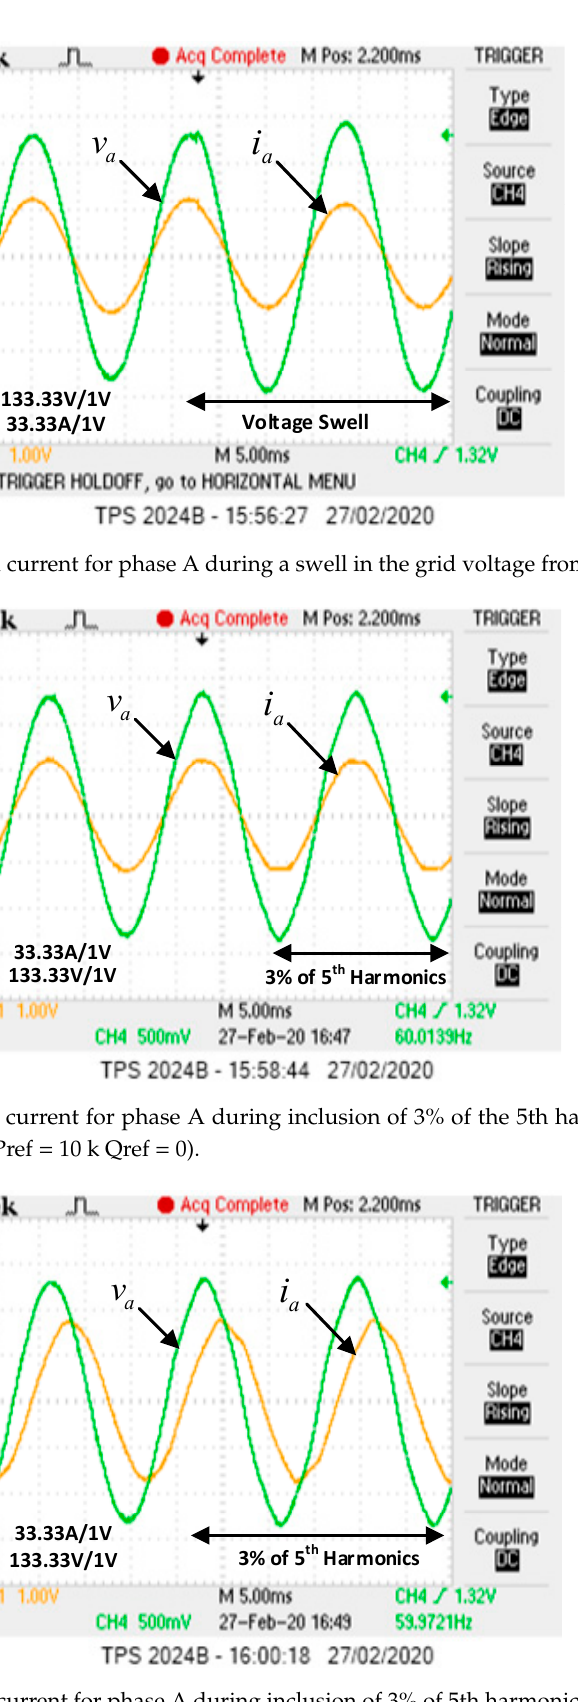
Figure 22. Voltage and current for phase A during V dc = 380 V + 38 V at 120 Hz. Pref = 10 kW and Qref = 10 kVar.